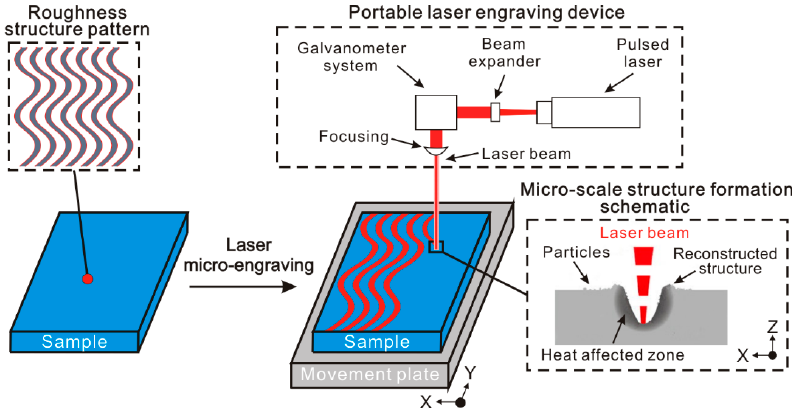
Figure 1. The treatment process and schematic of the micro-scale roughness structure construction approach (laser micro-engraving).